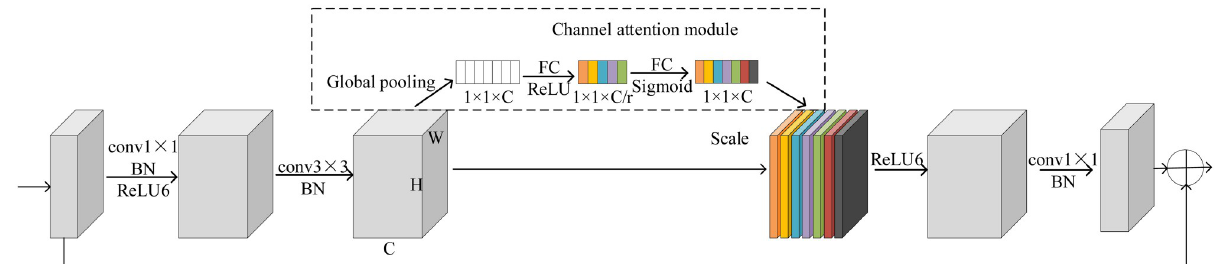
Fig 2. The detail network structure of improved Bottleneck module with the attention